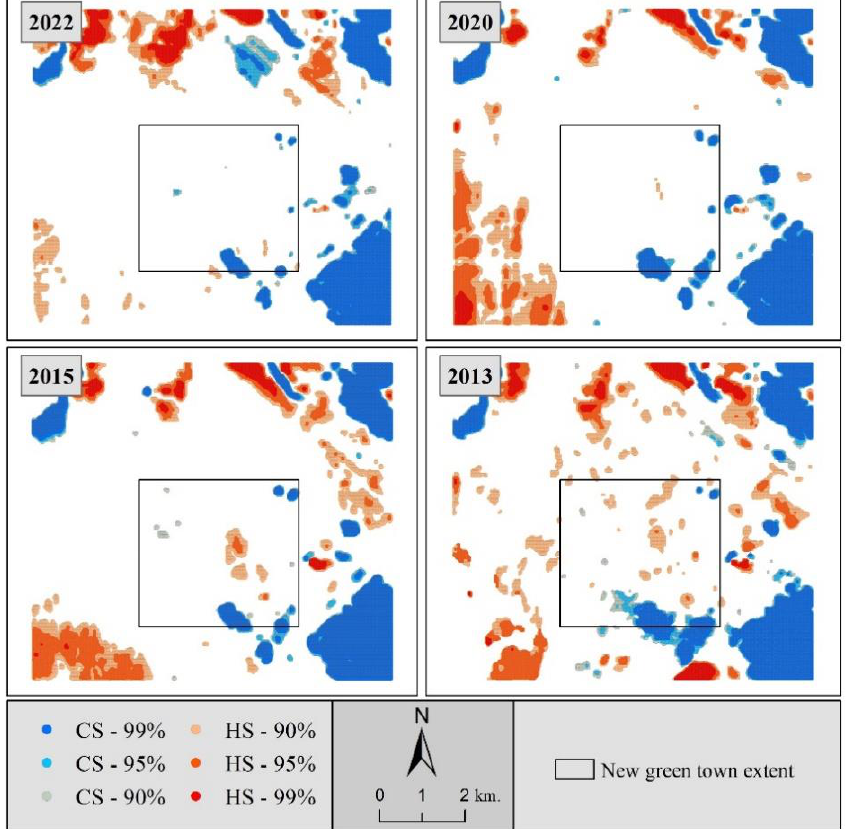
Figure 12. Hot spot (HS) and cold spot (CS) maps of the studied area for 2013, 2015, 2020 and 2022.